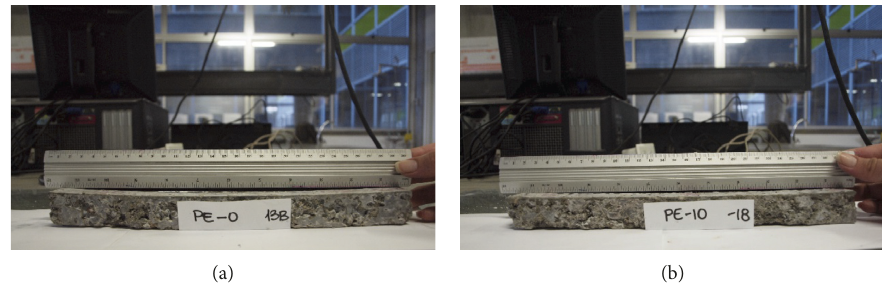
Figure 6: Concrete exposed to MgSO